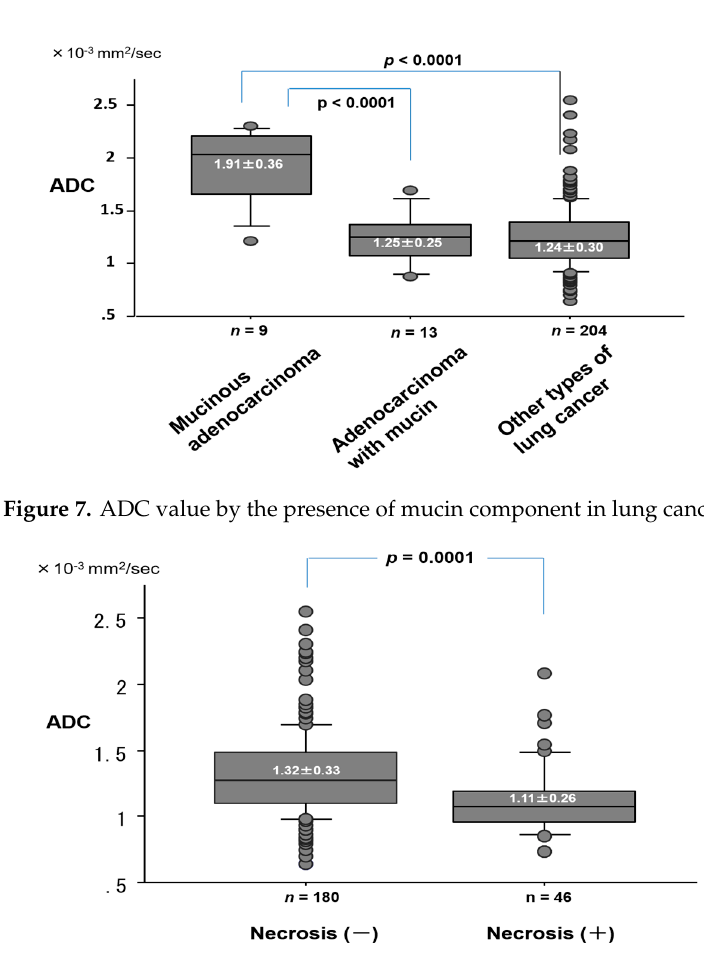
Figure 8. ADC value by the presence of necrosis in lung cancer.